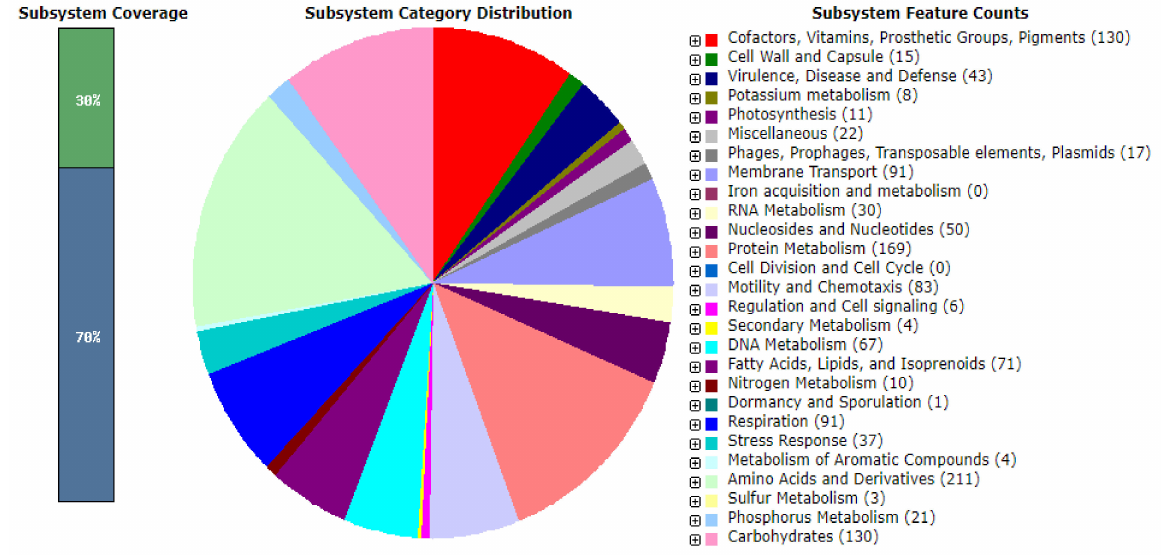
Figure 4. Subsystem category distribution of strain NZ-12B T based on the RAST annotation server (https://rast.nmpdr.org/) (accessed on 21 August 2021). Table 2. Characteristic gene products related to deep-sea survival present in the genome of strain NZ-12B T